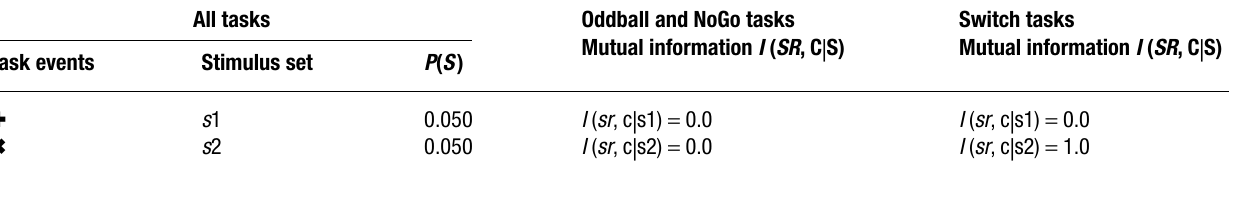
Table 2. Mean stimulus probability, P ( S ), and a priori estimations of mutual information between contextual stimulus information (C|S) and available S–R mappings, I ( SR , C|S), for the 3 task-sets in depicted in Figure 1. Shannon’s (1948) joint entropy H x y notion of mutual information were used to estimate information transmission between black symbols and S–R mappings (cf. “contextual control” in Koechlin et al., 2003).